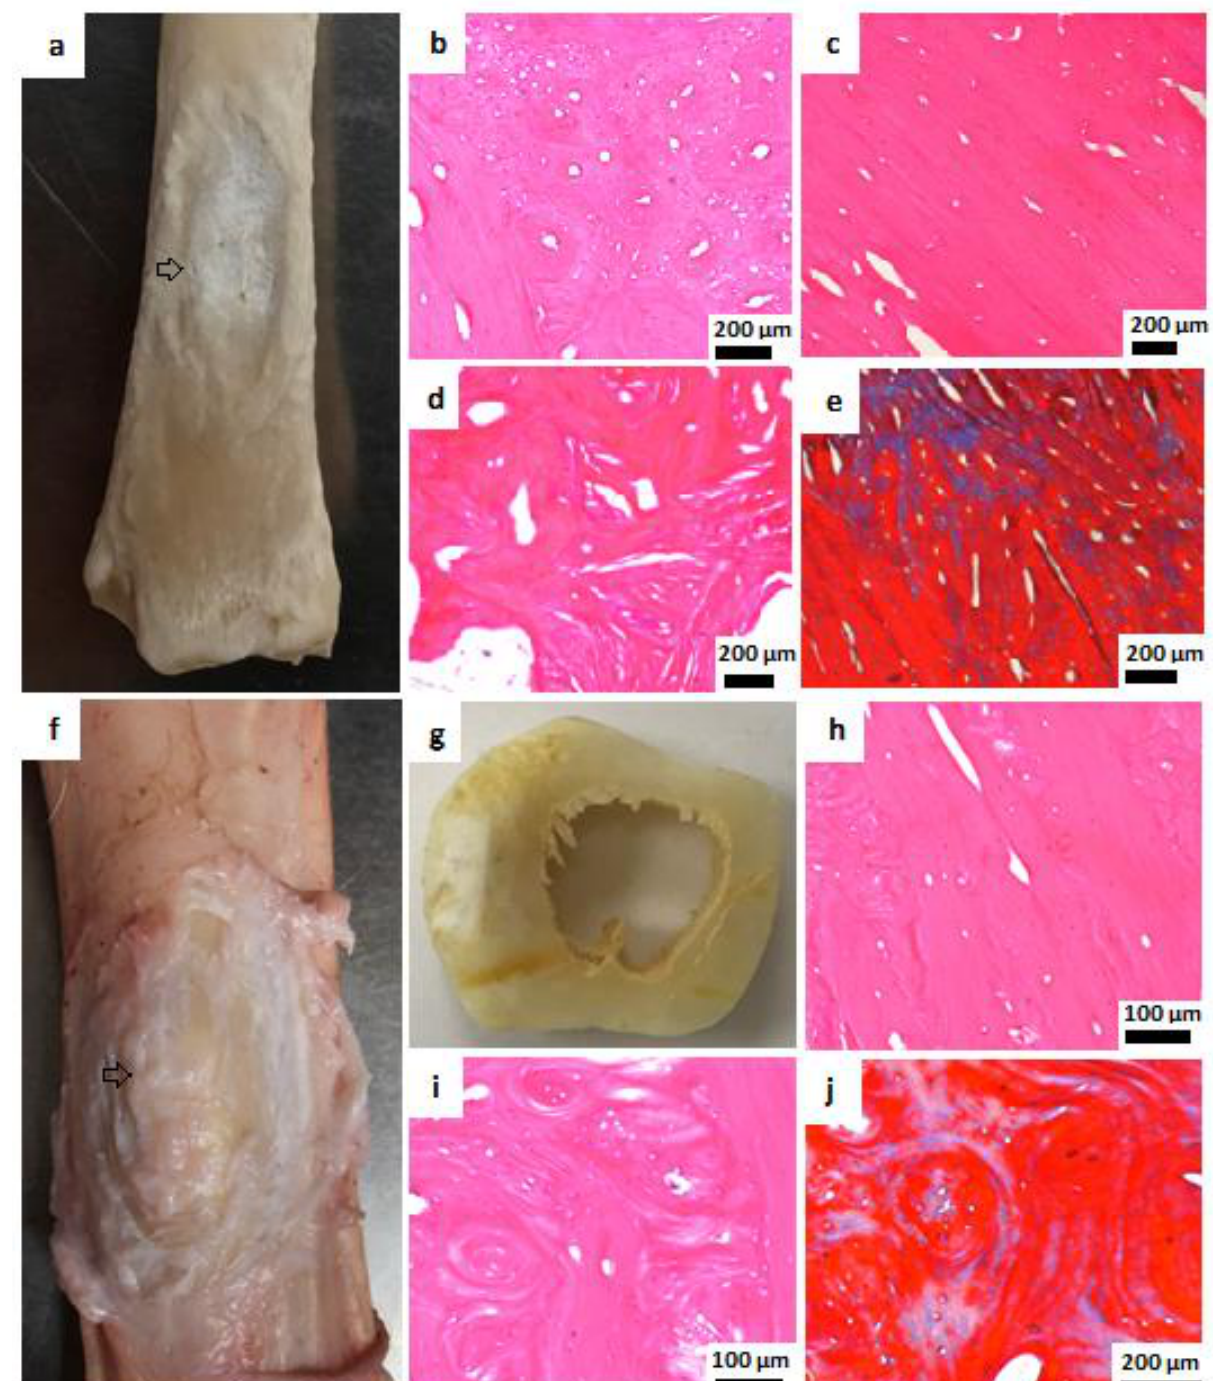
Figure 7. Macroscopic and histological examination of bone tissue 6 months after HA plates implan- tation. ( a ) Macroscopic view, metatarsal bone, arrow: complete resorption of perforated HA plate and new bone formation. ( b – d ) Newly formed cortical bone, H&E, 200 µ m. ( e ) Masson’s trichrome staining, 200 µ m. ( f , g ) Macroscopic view, unresorbed nonperforated HA plate covered by new bone tissue. The arrow points to the defect site in which new bone has formed over the nonperforated plate ( h , i ) New cortical bone, H&E, 100 µ m. ( j ) New cortical bone, Masson’s trichrome staining, 200 µ m.